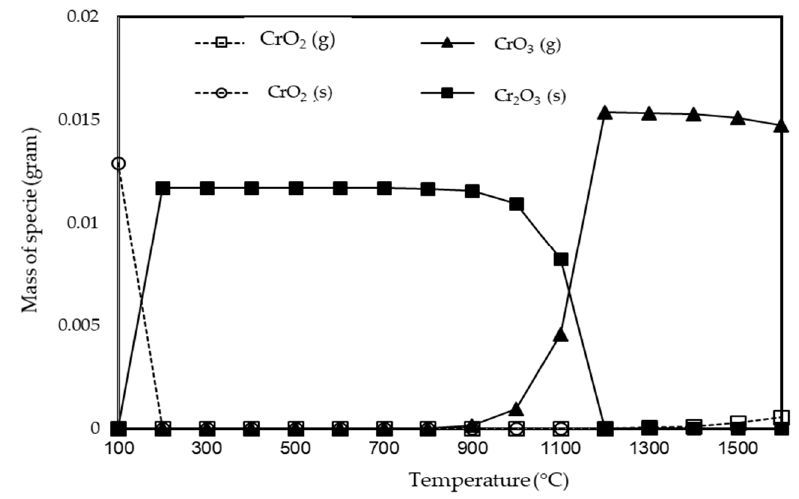
Figure 4. Equilibrium composition of Cr considering Cr FA A component interactions. Table 5. Interaction of predicted chromium (CrO 2 ) with mineral components during leaching